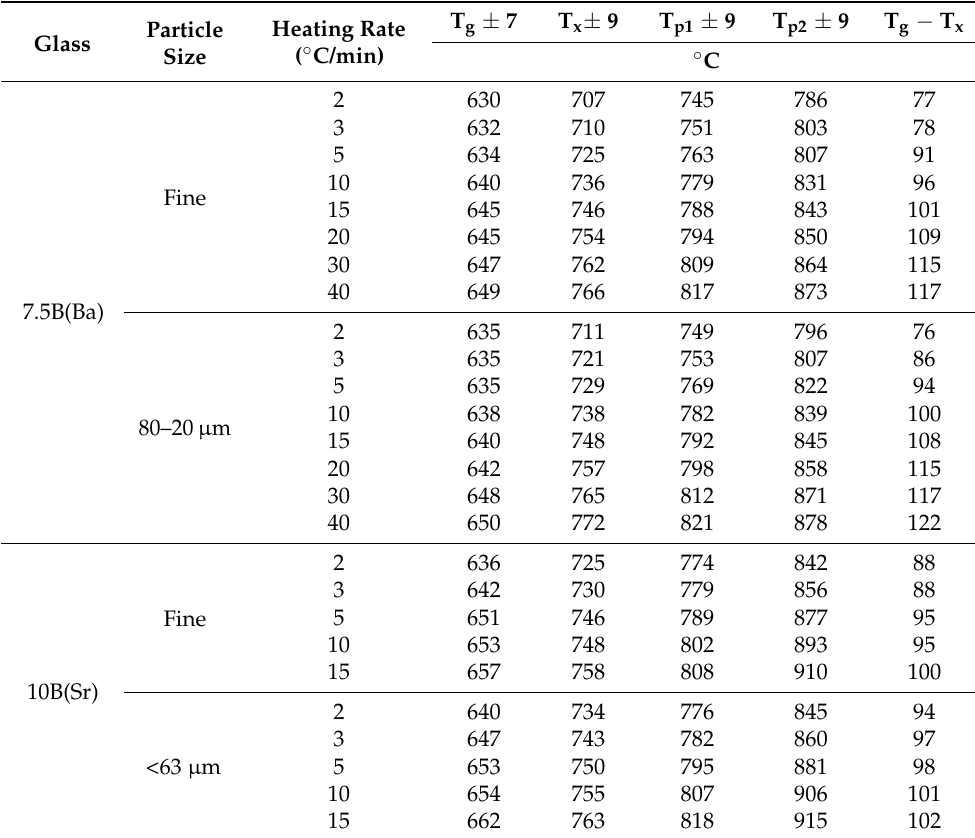
Table 4. Characteristic temperatures obtained from the DTA